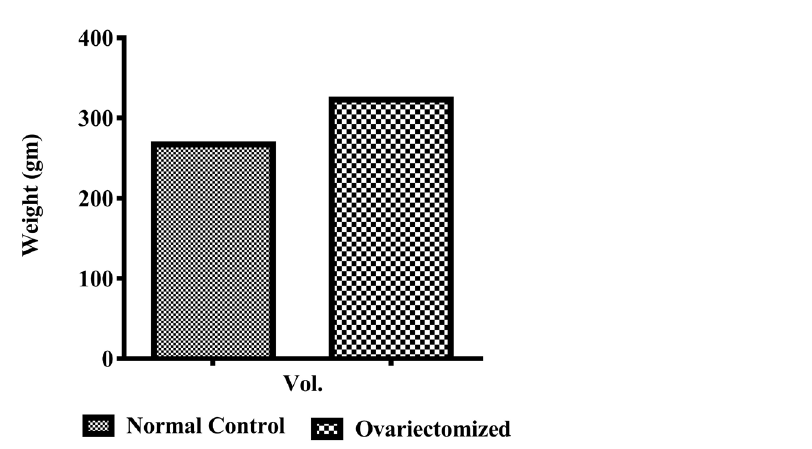
FIGURE 5 - Effect of ovariectomy on body weight. Values are expressed as mean